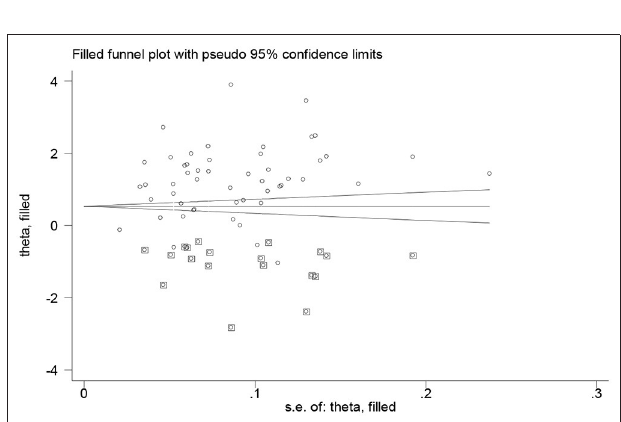
FIGURE 3 | The trim and fill analysis to hand out the publication bias of the included